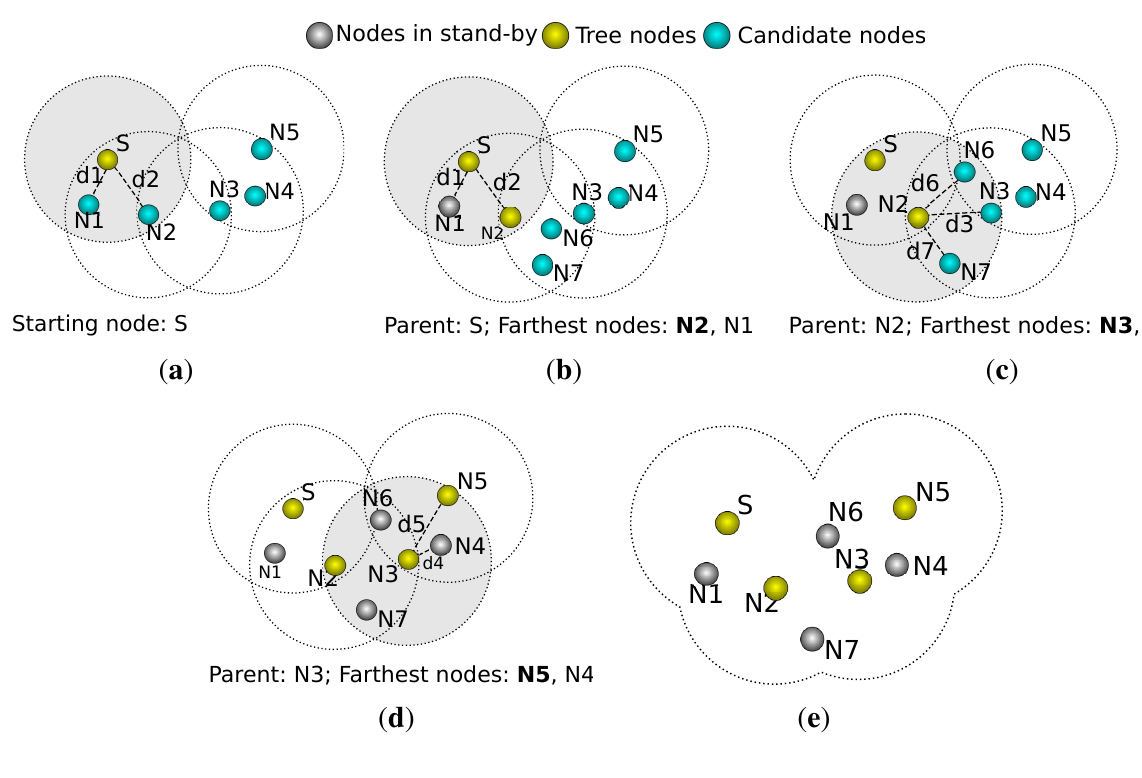
Figure 5. Overview of A3 . ( a ) Nodes 1 and 2 are candidates; ( b ) Node 1 sleeps, 2 is chosen; ( c ) Node 2 acts as a parent; ( d ) Nodes 3 and 6 sleep, node 5 is chosen; ( e ) CDS tree nodes are